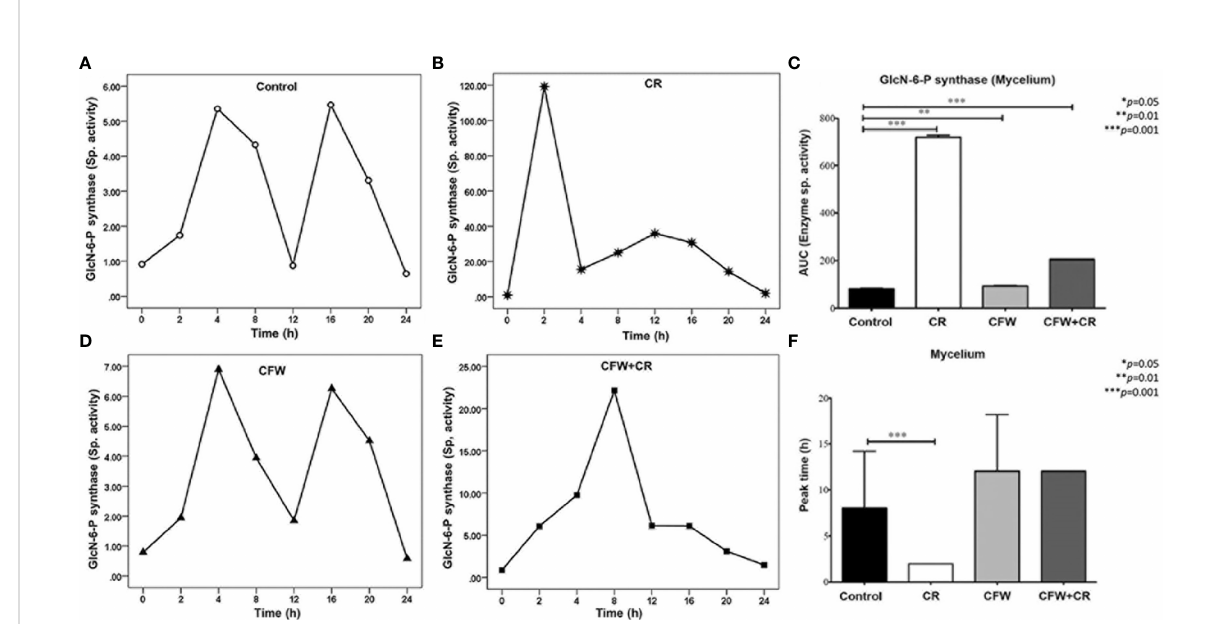
FIGURE 8 Responses of GlcN-6-P synthase of the mycelium of S. globosa to CW damage induced by CR and CFW. Mycelia was propagated in the absence and the presence of the dyes either alone or in combination. After the indicated times, cells were processed to measure enzyme activity. Control culture and those containing CR, CFW and the mixture are illustrated in Figures (A) (B) (C) and (D) respectively. Statistics analyses were carried out by calculating the area under the curve (AUC) (E) and the time required for the enzyme to reach its maximum activity (F) . Reproduced from Ortiz-Ramirez et al., 2021, with permission from Springer Nature, License Number 5315470121400 (May 24,